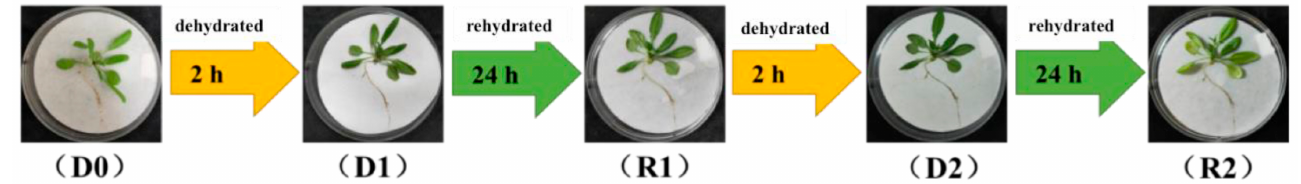
Figure 6. Schematic diagram of the Arabidopsis drought training.